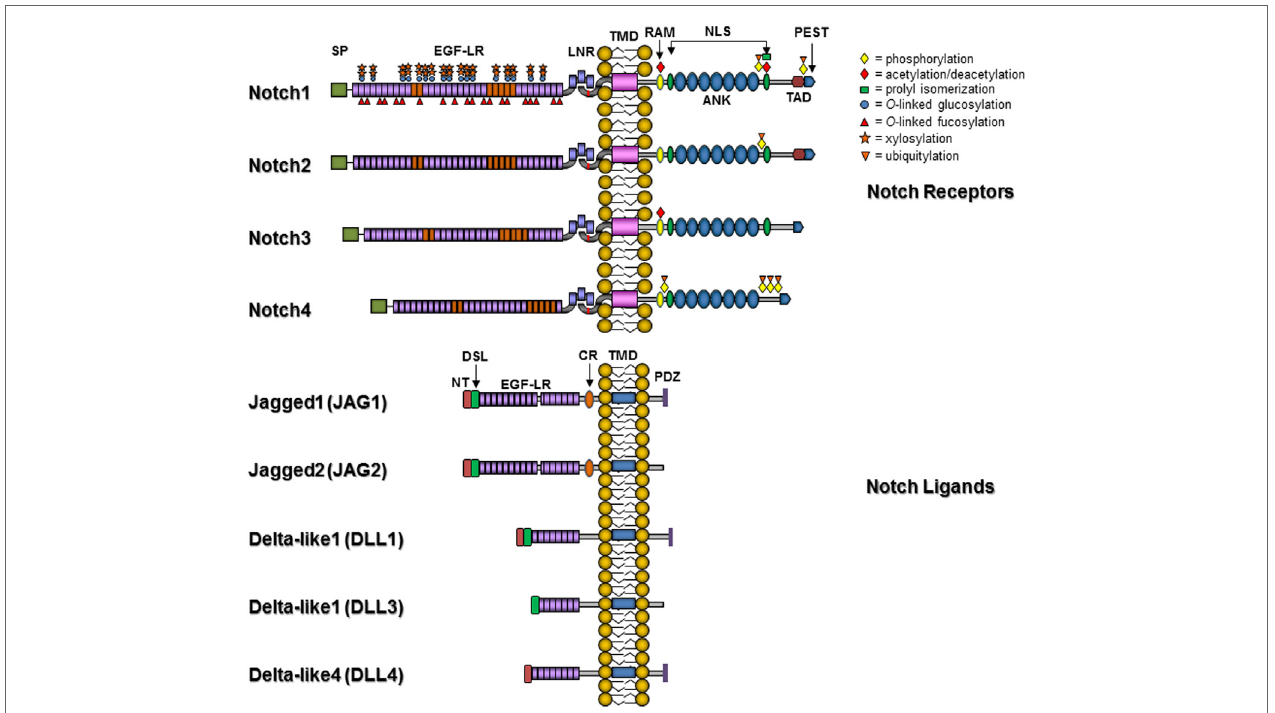
FiGURe 2 | Notch receptors and ligands . Abbreviations: SP, signal peptide; EGF-LR, epidermal growth factor-like repeats; LNR, Lin-Notch repeat; TMD, transmembrane domain; RAM, RBP-J κ association module 23; NLS, nuclear localization signal; ANK, ankyrin/CDC10 repeat; TAD, transactivation domain; PEST, proline/glutamic acid/serine/threonine-rich motif; PDZ, PSD-95/Dlg/ZO-1 domain; CR, cysteine-rich domain; DSL, Delta/Serrate/Lag2 domain; NT, N-terminal domain. Posttranslational modifications are indicated by symbols: yellow diamonds, phosphorylation; red diamonds, acetylation/deacetylation sites; green square, prolyl isomerization site; blue circle, O-linked glucosylation; red triangle, O-linked fucosylation; orange star, xylosylation; and inverted orange triangle,